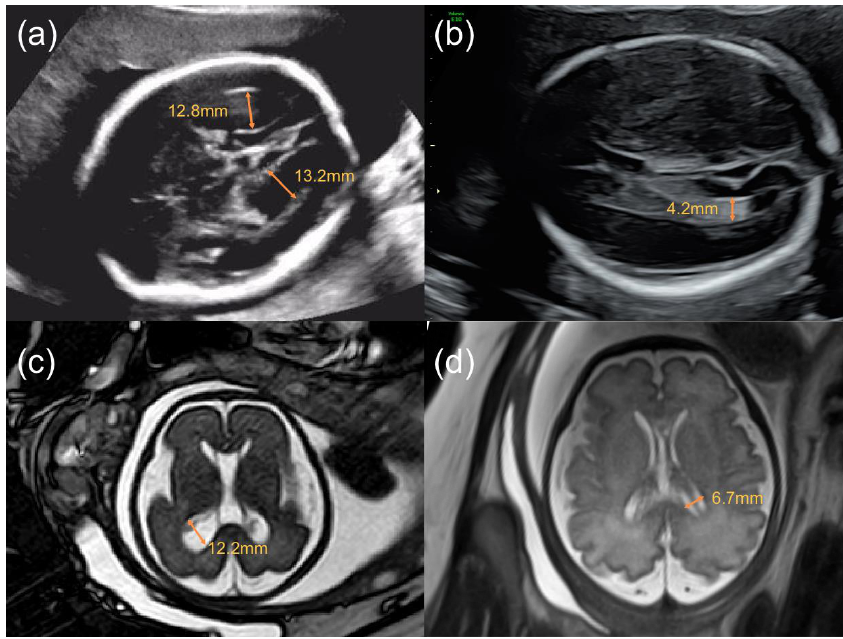
Figure 1. Images of transabdominal ultrasound ( a , b ) and fetal MRI ( c , d ) demonstrating normal and abnormal lateral ventricles. ( a ). Axial ultrasound image at 27 4/7 gestational weeks, singleton pregnancy, showing fetal bilateral ventriculomegaly with left lateral ventricle = 12.8 mm, right lateral ventricle = 13.2 mm; ( b ). Axial ultrasound image at 23 6/7 gestational weeks, singleton pregnancy, showing normal lateral ventricle; ( c ). Axial T2 fetal MR image at 27 3/7 gestational weeks, singleton pregnancy, showing fetal unilateral ventriculomegaly with left lateral ventricle = 12.2 mm; ( d ). Axial T2-SSFSE (single-shot fast spin echo) fetal MR image at 32 gestational weeks, singleton pregnancy, showing normal lateral ventricle.